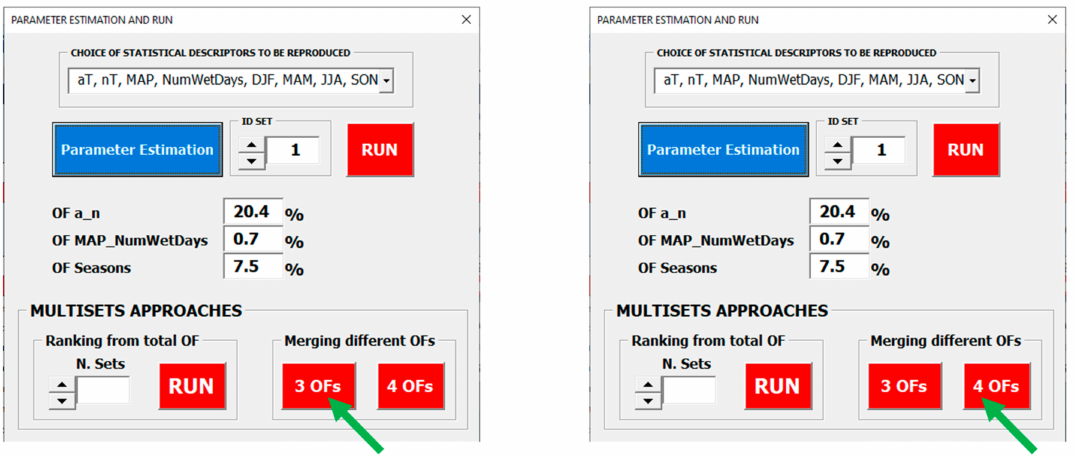
Figure 13. Use of multisets approach regarding the option “Merging different